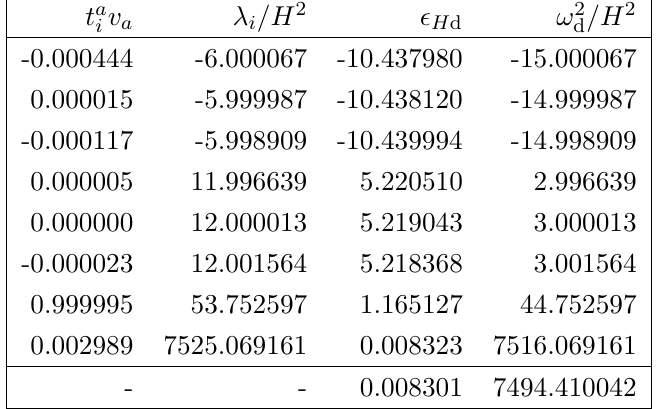
along with each ? of the O ( δ 0 ) aligned Hessian k = λ or λ k u k < 6 . 95 and ω 2 . 17 . V ≈ extreme /H ≈ (irrelevant for the flux